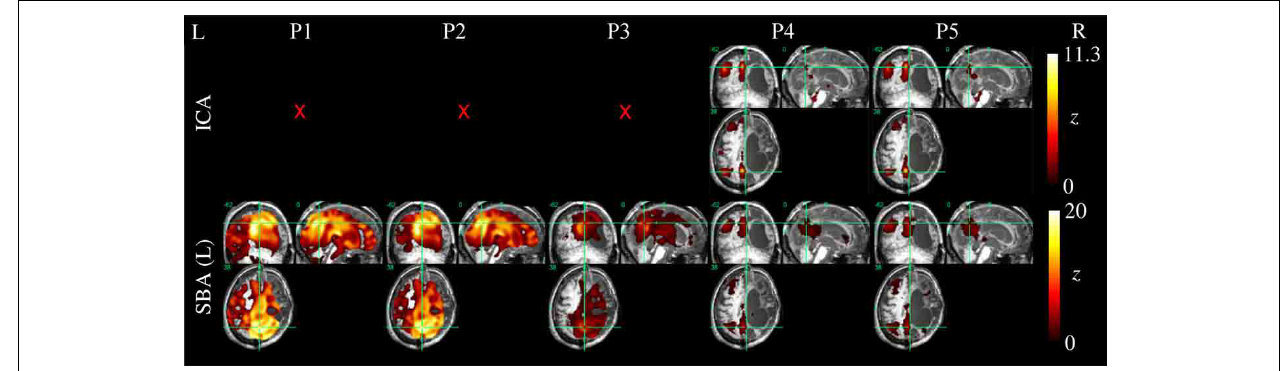
FIGURE 8 | DMN functional connectivity maps computed with ICA (top row) and SBA (middle and bottom rows) for a patient with a clinical diagnosis of minimally-conscious state (maximum displacement 20.3mm, 16/200 outlier volumes); red crosses denote inability to identify DMN activity in any of the 20 components extracted by ICA. Due to the gross anatomical damage visible on the volumetric T 1 scan, SBA with